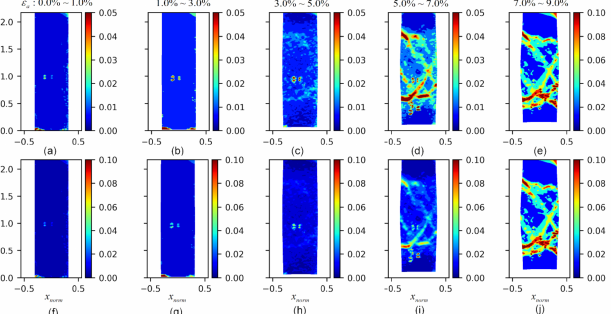
Figure 10. The evolution of the standard deviation fields of the gradient along the ˆ y axis F 33 : ( a – e ) the mean fields of F 33 at axial strains of 0.0–1.0%, 1.0–3.0%, 3.0–5.0%, 5.0–7.0%, and 7.0–9.0%, respectively, with varying range colormaps; ( f – j ) the mean fields of F 33 at axial strains of 0.0–1.0%, 1.0–3.0%, 3.0–5.0%, 5.0–7.0%, and 7.0–9.0%, respectively, with consistent range